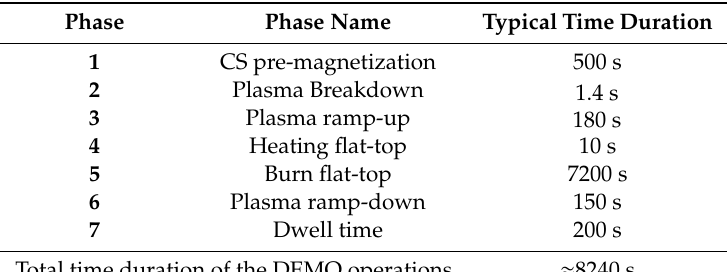
Table 1. Summary of the DEMO operation phases with typical